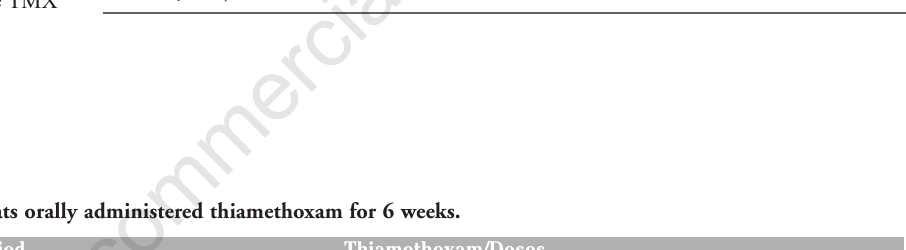
Figure 3. Photomicrograph of rat kidney stained with hematoxylin and eosin: The histo- logical structure of the renal cortex is intact in control rats and TMX low dose (A and B). Rats treated with TMX at 39 mg/Kg/b.w and 78 mg/Kg/b.w respectively (C and D) shows mild congestion in the glumeroli, and vacuolar degeneration of tubular cells (A, B, C and D H&E;